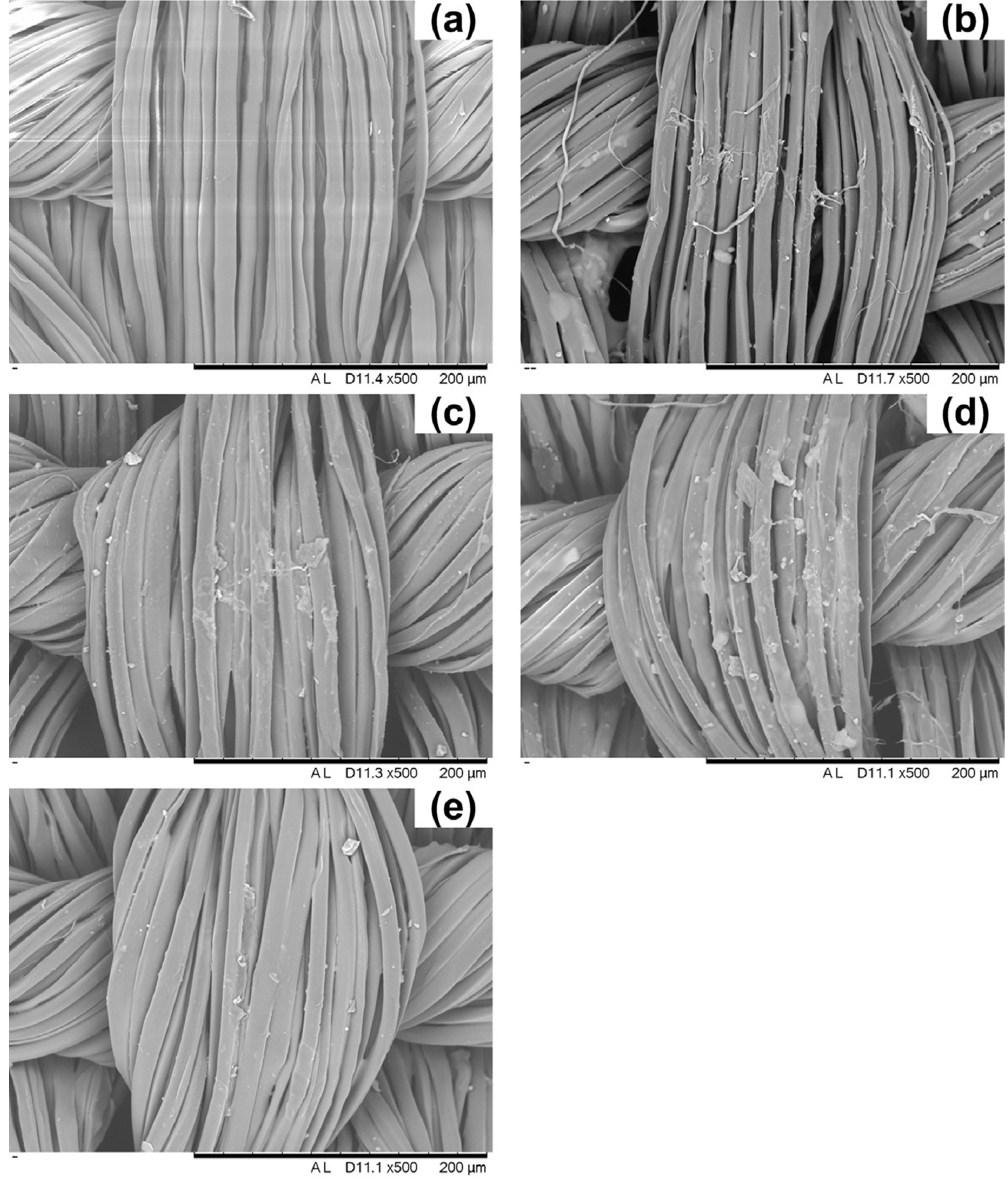
Figure 9. SEM micrographs of the untreated silk fabric ( a ) and the silk fabrics treated with the hybrid sols unmodified ( b ) and modified by APDTMS ( c ), CPTS ( d ) and MPTS ( e ). Reproduced with permission from [57]. Copyright 2018, Elsevier.